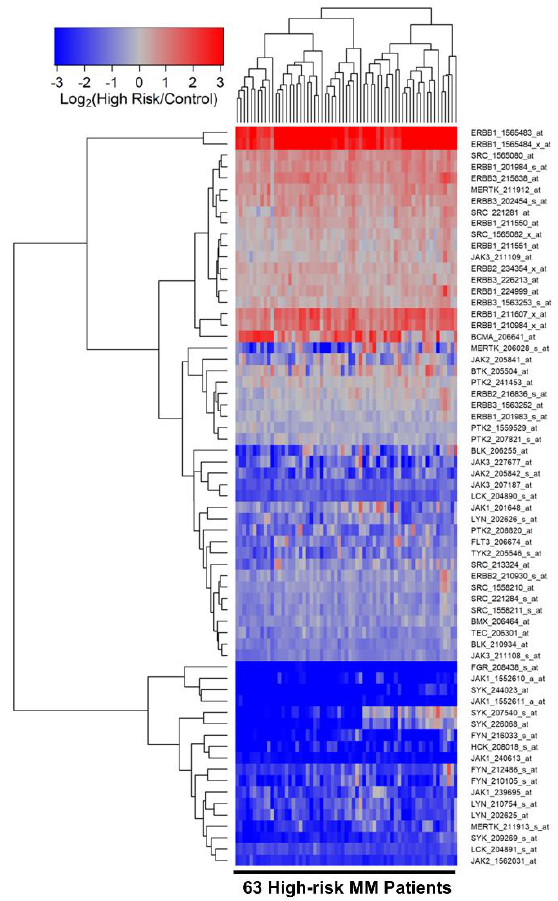
Figure 2. Gene Expression Levels for Tyrosine Kinases in Malignant Plasma Cells from High-Risk MM Patients vs. Normal Plasma Cells from Healthy Subjects. We examined the gene expression data in the archived MM dataset GSE19784 and the control plasma cell dataset from GSE171739. The cluster figure displays the expression levels in malignant plasma cells from 63 high-risk MM patients mean centered to the expression levels in normal plasma cells for log 2 -transformed fold-change values (blue represents underexpression and red color represents overexpression in MM cells). Patients were risk-categorized based on the patient-specific EMC-92/SKY-92 gene expression signature values. The expression levels of co-regulated probesets for both probesets (rows) and patients (columns) are organized in the depicted dendrograms. The comparison of the log 2 -transformed RMA values for normal plasma cells from 7 control samples with RMA values for malignant plasma cells from 63 high-risk MM patients showed that 47 probesets were significantly dysregu- lated of which 10 were upregulated in the malignant plasma cells from high-risk MM patients (FDR = 0.07). ERBB1_1565483_at was the most significantly upregulated probeset (Fold Change = 22.39; p - value < 1 × 10 −8 ) followed by ERBB1_1565484_x_at (Fold Change = 11.94; p -value < 1 × 10 −8 ) and ERBB1_211607_x_at (Fold Change = 2.55; p -value = 1.9 × 10 −6 ) (Table S4). Five out of the 10 upregu- lated probesets were for the ERBB1 gene and 2 probesets for the ERBB3 gene. In addition, MERTK, SRC and BCMA were also significantly upregulated in malignant plasma cells. Co-regulation of BCMA and 2 probesets of ERBB1 are depicted in the cluster figure. 3.2. Differentially Amplified Expression of ERBB1/EGFR and JAK3 Genes in Malignant Plasma Cells from High-Risk MM Patients We compared the transcript-level PTK expression profiles of malignant plasma cells from high-risk (N = 63) vs. standard-risk (N = 219) MM patients. Notably, the expression levels of ERBB1/EGFR and JAK3 were differentially amplified in malignant plasma cells from high-risk MM patients (Figure 3, Table S5).